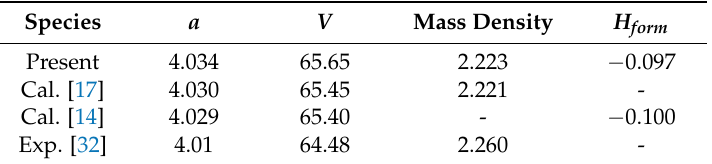
Table 1. Simulated lattice constant a (Å), volume V (Å 3 ), mass density (Kg/m 3 ), and formation enthalpy H form (eV) of pure Al 3 Li phase at 0 K.